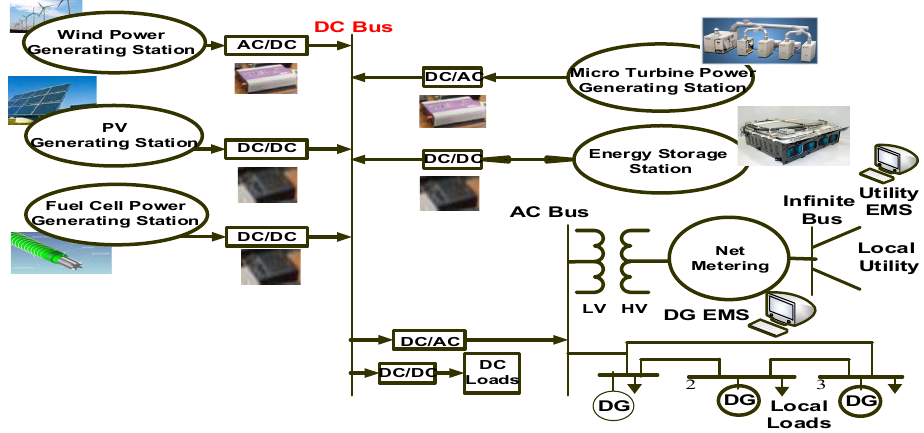
Figure 1. Structure of a (DC) microgrid.